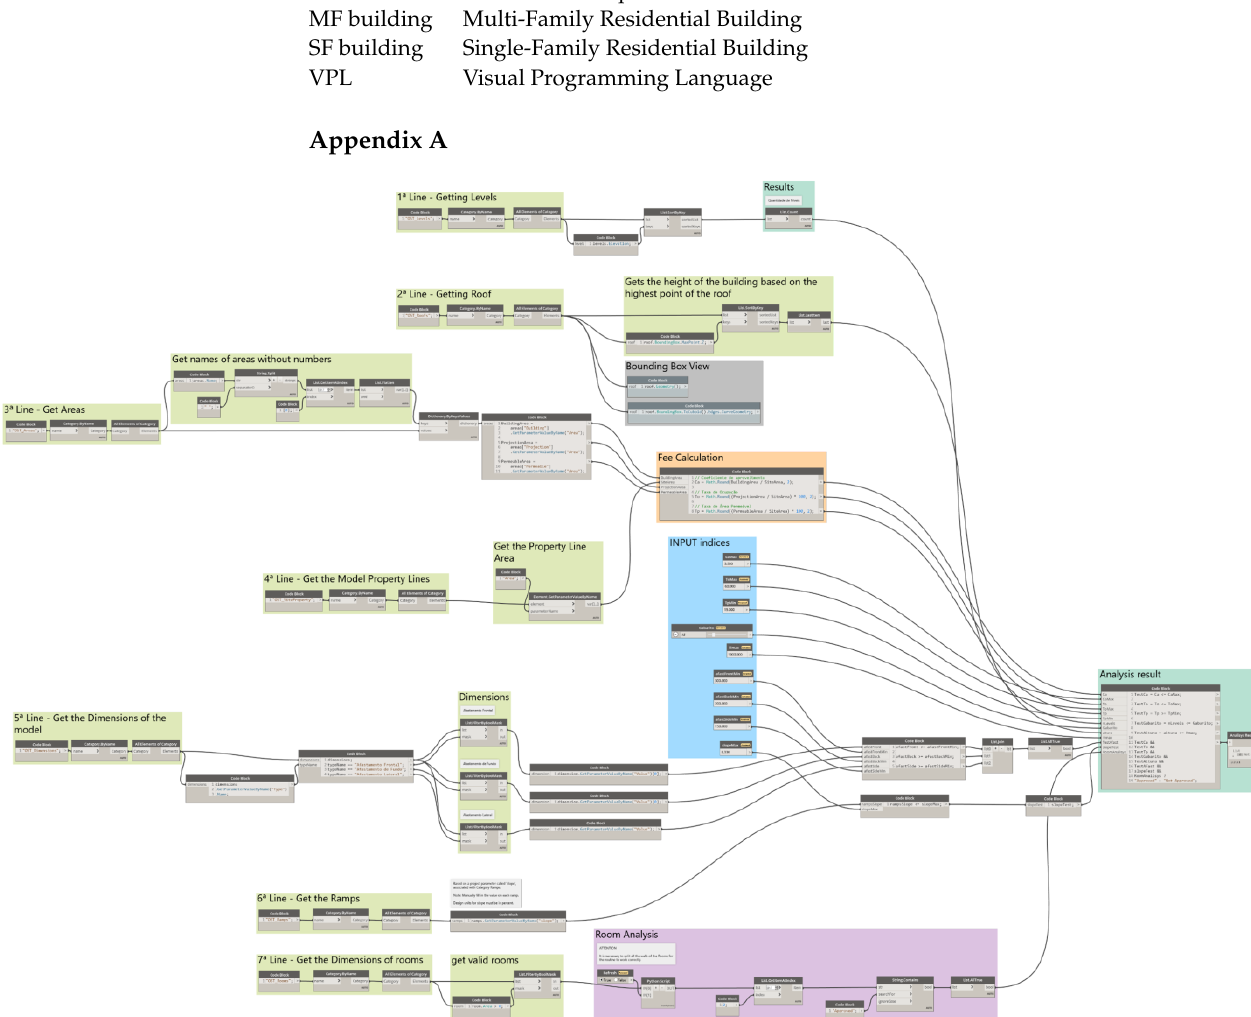
Figure A1. Dynamo routine.